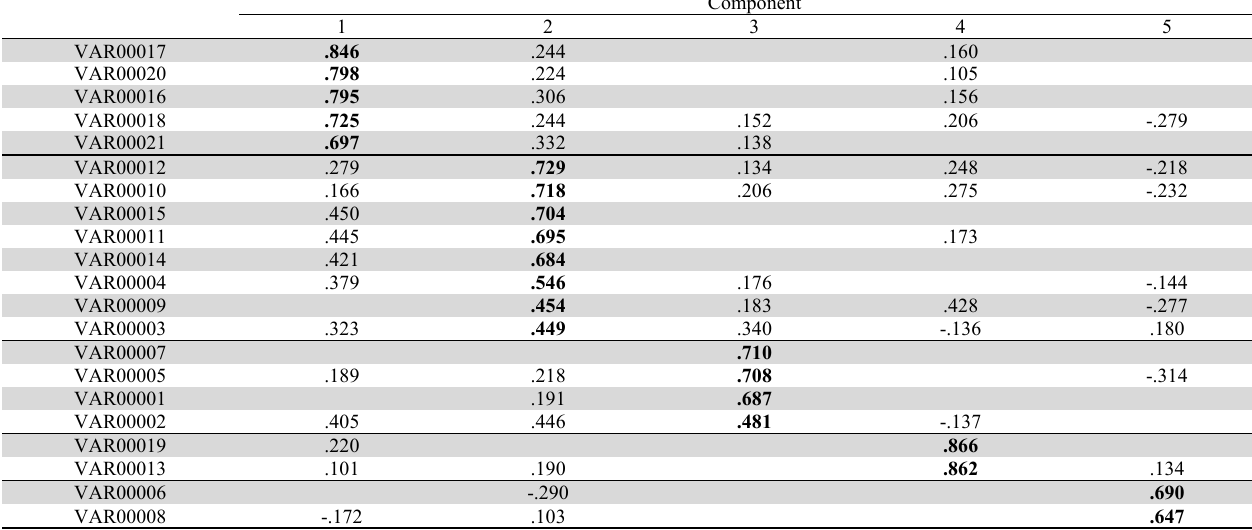
Rotated Component Matrix